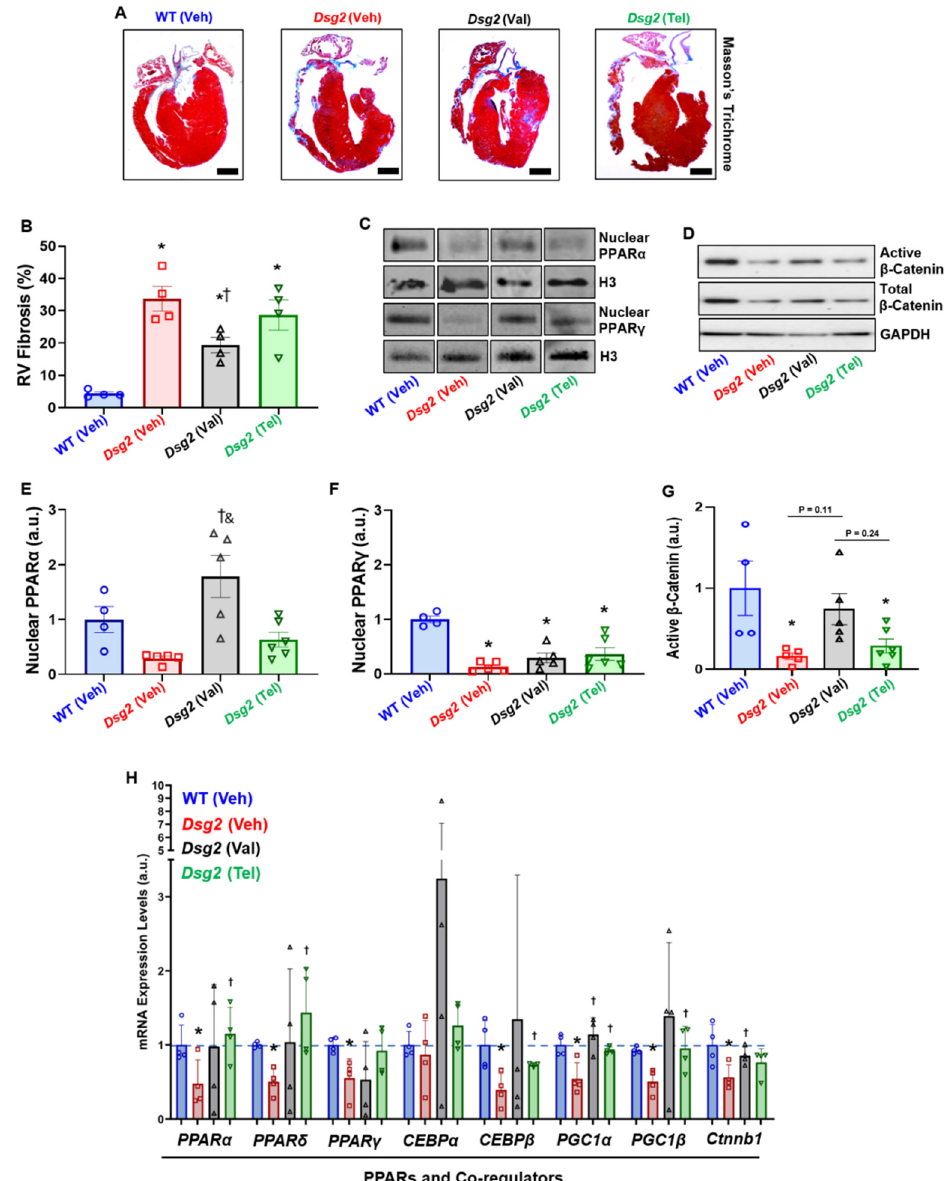
Figure 2. Cardiac histopathological analysis and nuclear PPAR α and PPAR γ levels in Vehicle- treated WT and ARB-treated Dsg2 mut/mut mice. ( A ) Representative cardiac tissue slices stained with Masson’s Trichrome for fibrotic lesions from Vehicle-treated WT mice and Dsg2 mut/mut mice treated with ARBs. Black scale bar, 1 mm. ( B ) Percent fibrosis of the right ventricle (RV) free wall. ( C , D ) Representative immunoblots probed for PPAR γ , PPAR α , active β -Catenin, total β -Catenin, and Histone-3 (H3). Immunoblot quantification of nuclear ( E ) PPAR α , ( F ) PPAR γ , and ( G ) active β -Catenin in Vehicle-treated WT mice and Dsg2 mut/mut mice treated with ARBs. ( H ) qPCR analysis of genes associated with PPARs and co-regulators. Data presented as mean ± SEM. * p < 0.05 for any cohort vs. Vehicle-treated WT mice; † p < 0.05 for any drug-treated Dsg2 mut/mut cohort vs. Vehicle- treated Dsg2 mut/mut mice; & p < 0.05 for Valsartan-treated Dsg2 mut/mut mice vs. Telmisartan-treated Dsg2 mut/mut mice One-way ANOVA with Tukey’s post-hoc analysis. Blue, WT vehicle-treated mice; pink, Dsg2 mut/mut Rosiglitazone-treated mice; black, Dsg2 mut/mut Valsartan-treated mice; green, Dsg2 mut/mut Telmisartan-treated mice; and red, Dsg2 mut/mut vehicle-treated